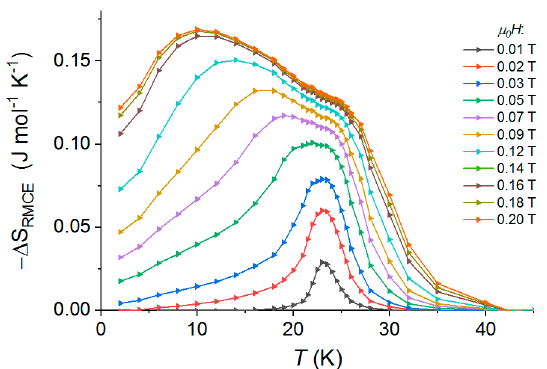
Figure 29. The magnetic entropy change with RMCE for 10 . Solid lines are guides for the eyes. Adapted with permission from Reference [72]. Copyright 2017 American Chemical Society.